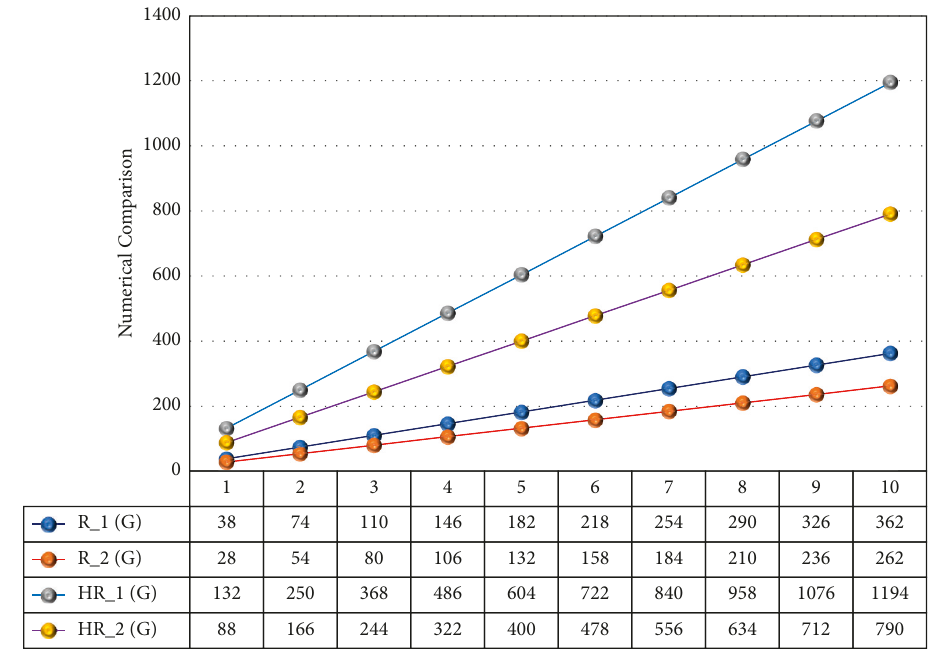
Figure 2: Comparison of R